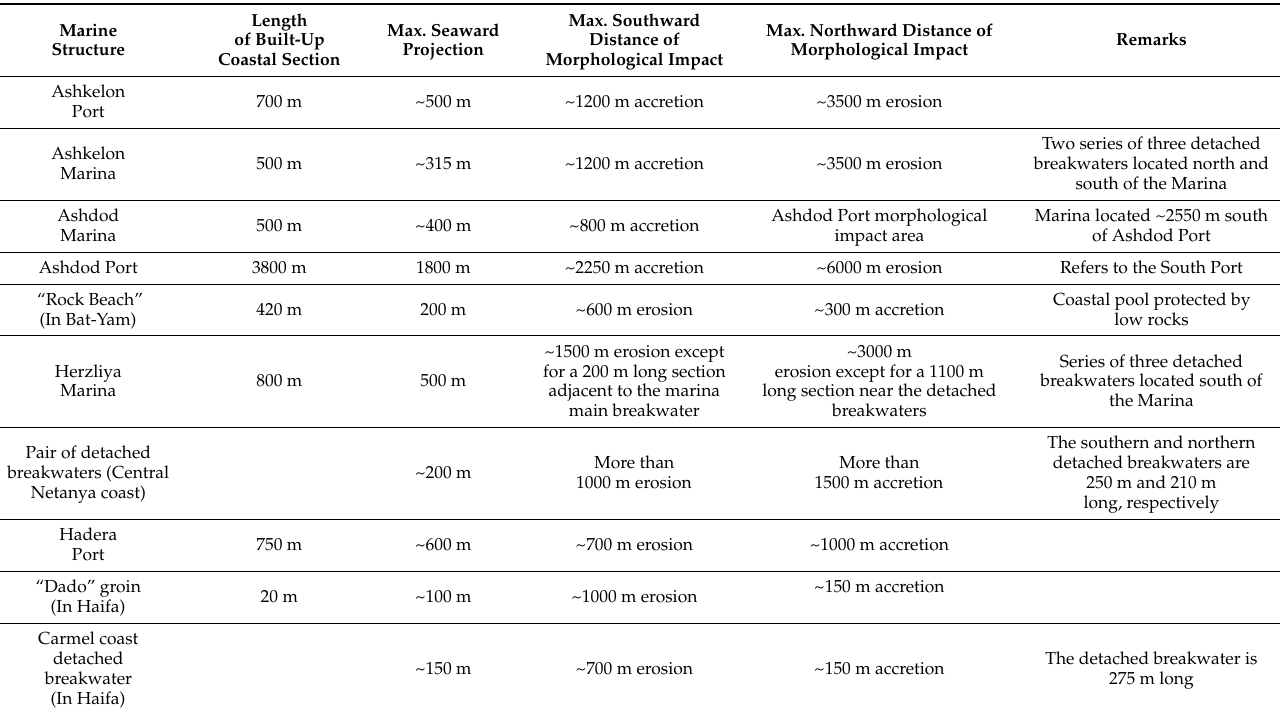
Table 1. Major marine structures on the Mediterranean coast of Israel